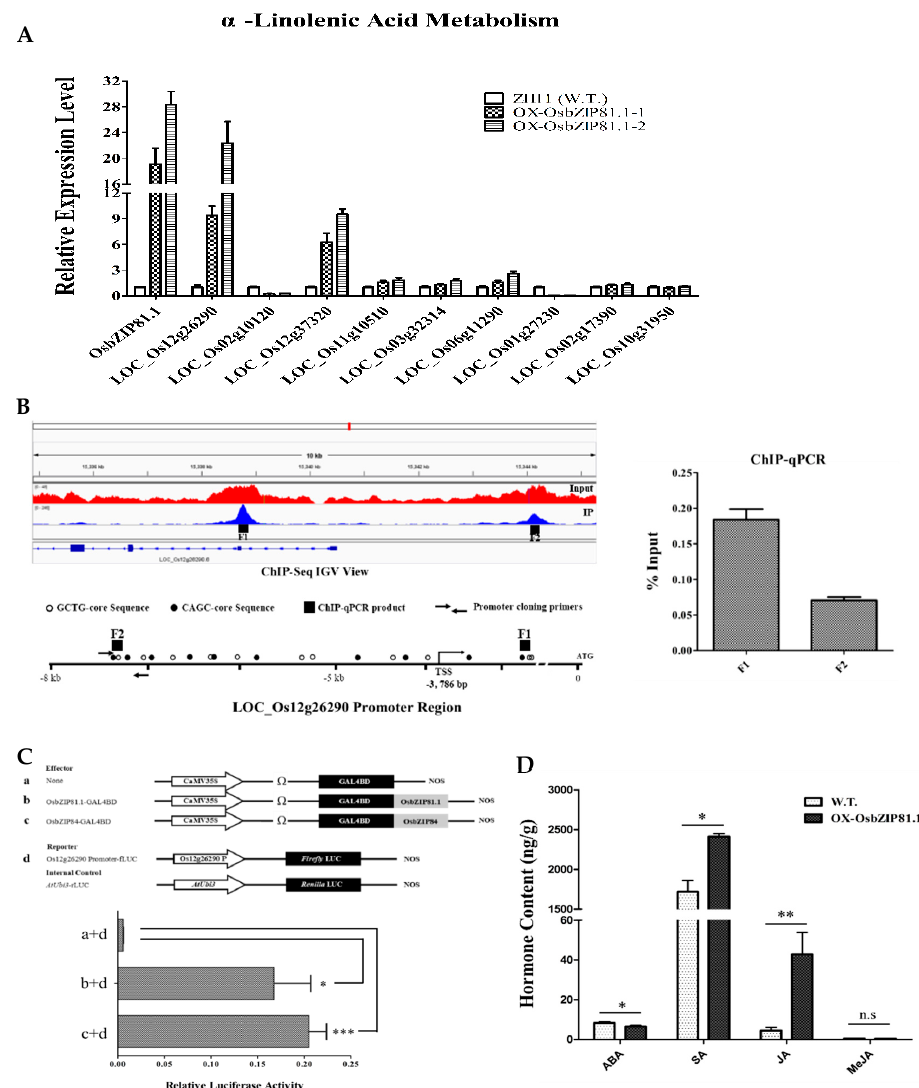
Figure 10. OsbZIP81.1 directly and positively regulates the expression of OsPIOX. ( A ) The expression level of genes enriched in α -linolenic acid metabolism pathway that were checked by RT-qPCR. ( B ) Peaks of OsPIOX in ChIP-Seq library and validation of the peaks by ChIP-qPCR. ( C ) Scheme of the constructs used in the rice protoplast cotransfection assay and the activities of different combinations were detected. The activity of GAL4-fLUC was used as the reporter and rLUC activity was used as an internal control. The fLUC/rLUC ratio represents the relative activity of the gene. The asterisks represent a significant difference determined by the Student’s t test, double asterisks indicate p -value < 0.01 and > 0.001, one asterisk indicates p -value < 0.05 and > 0.01, and n.s indicates p -value > 0.05. ( D ) Measurement of the ABA, SA, JA, and MeJA content in wild type Zhonghua 11 and OsbZIP81.1 overexpression transgenic rice plant (OX-OsbZIP81.1). The values in each column are the means of three independent replicates and error bars represent the